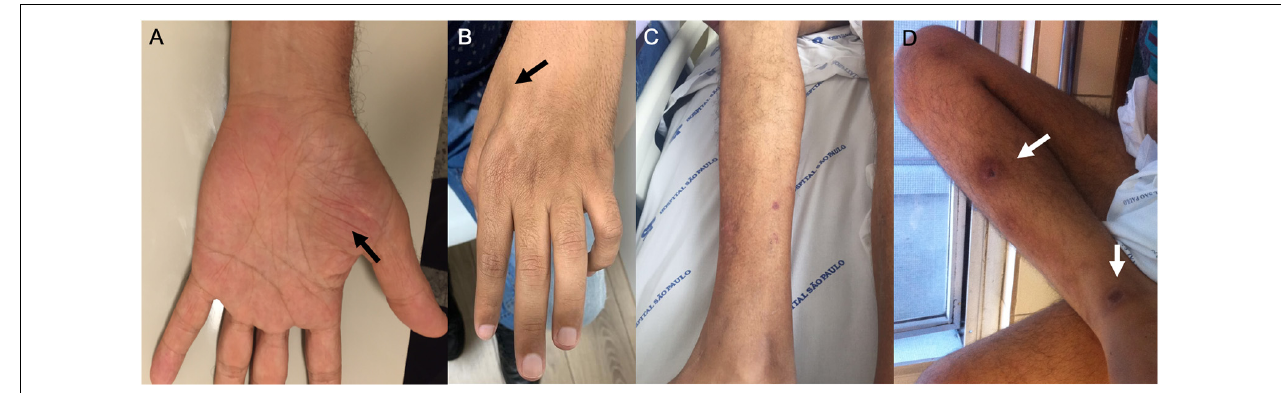
FIGURE 2 | Examination findings in patients with AHP. (A) Amyotrophy of the tenar region (black arrow) and (B) severe amyotrophy of the first dorsal interosseous muscle of the hand (black arrows) in patients with variegate porphyria. (C,D) Distal amyotrophy and photosensitivity lesions in the lower limbs (white arrows) in patients with hereditary